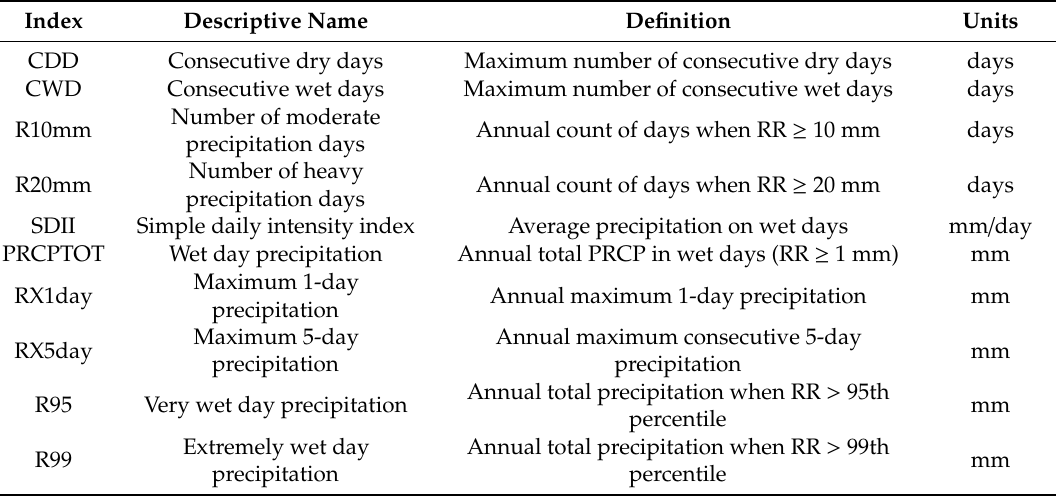
Table 2. Indices of extreme precipitation used in this